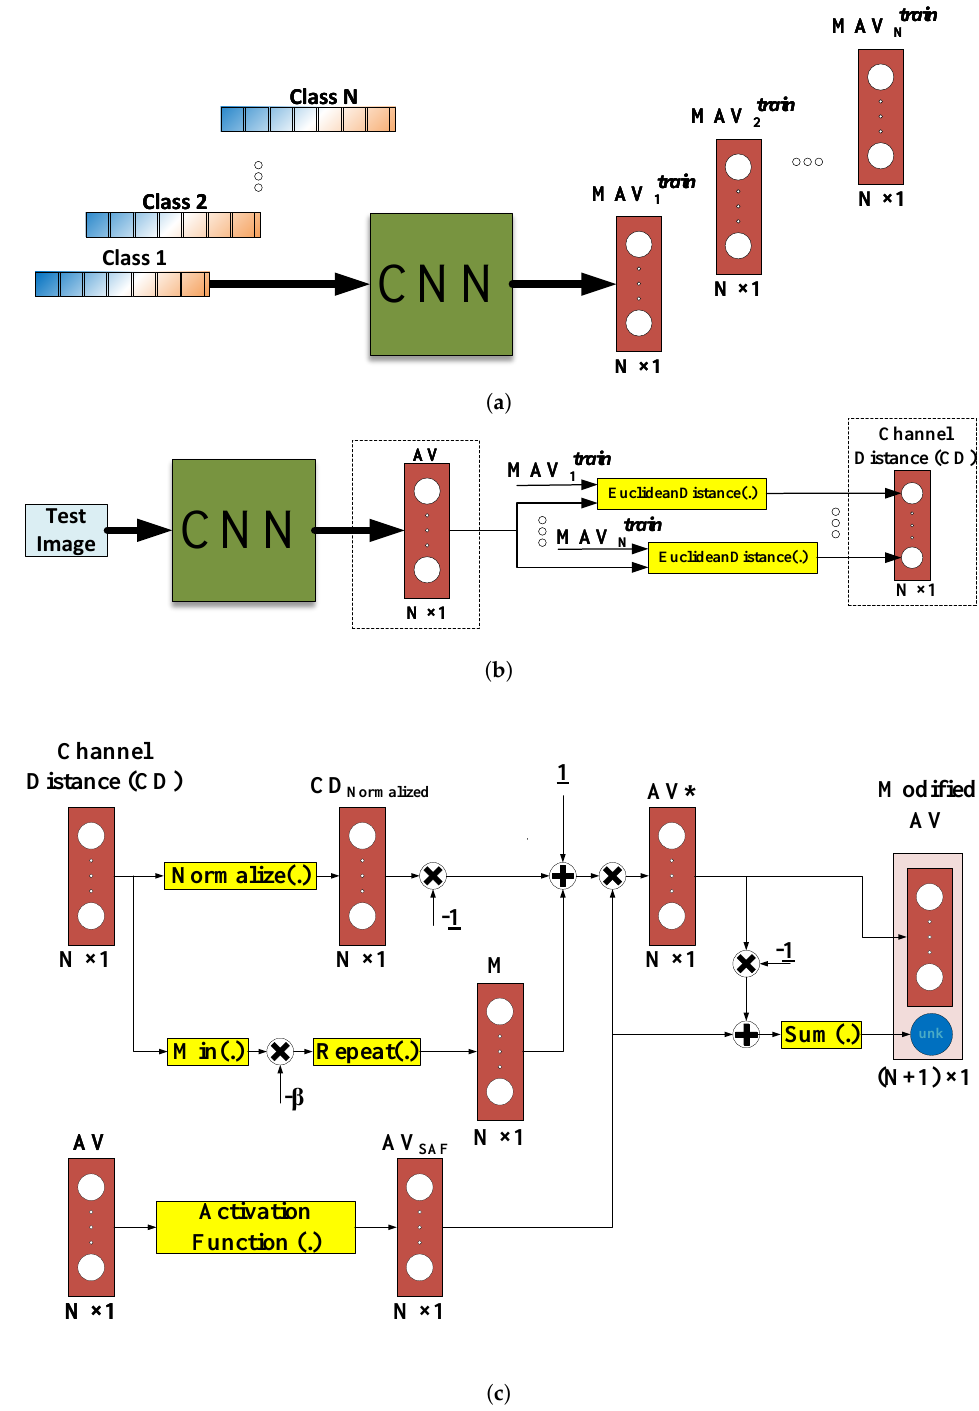
Figure 2. The overall framework of the PS-based Openmax classifier: ( a ) Calculation of MAVs. ( b ) Activation vector of the test image and Channel Distance vector. ( c ) Modification of the